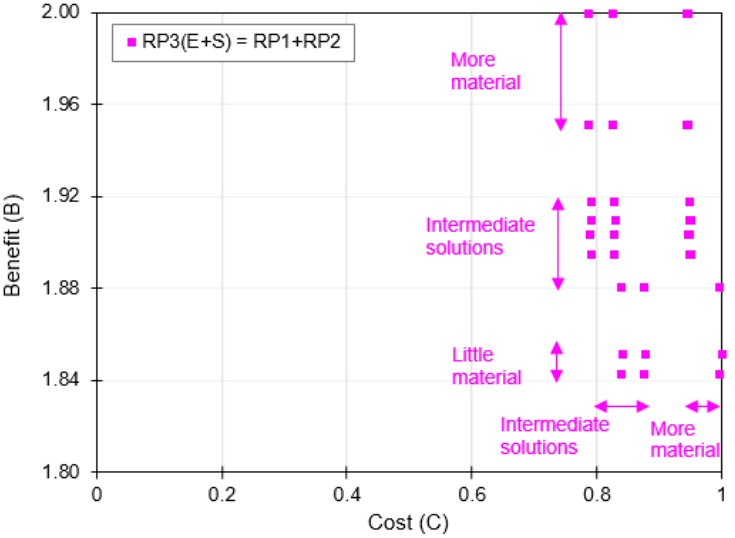
Figure 18. Combined energy and seismic benefit and cost of each integrated RP3 retrofitting configuration considered.